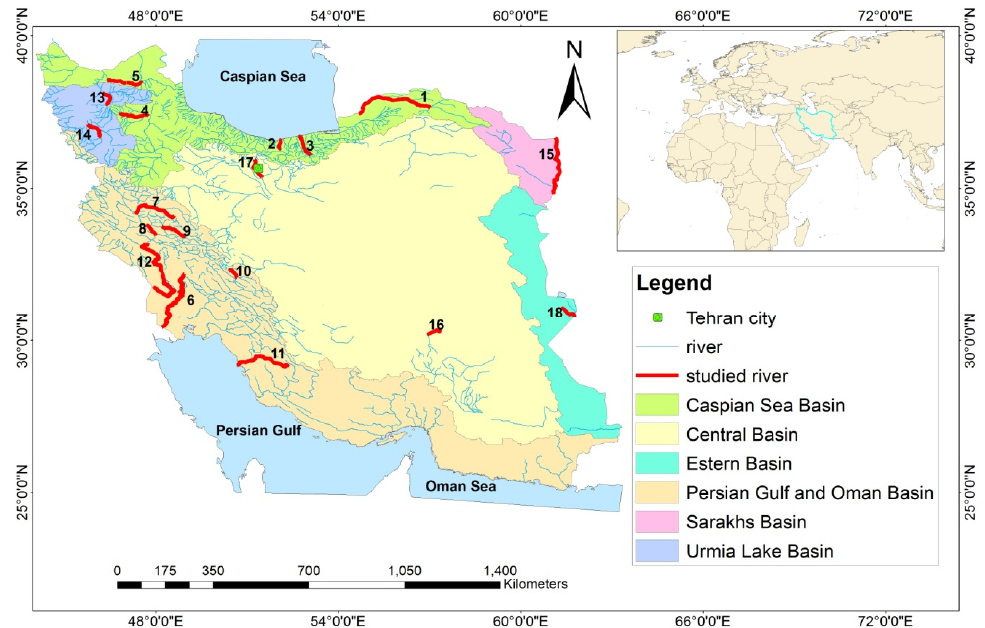
Figure 1. Location map showing Iranian river network, main drainage basins, and rivers analyzed in this study.